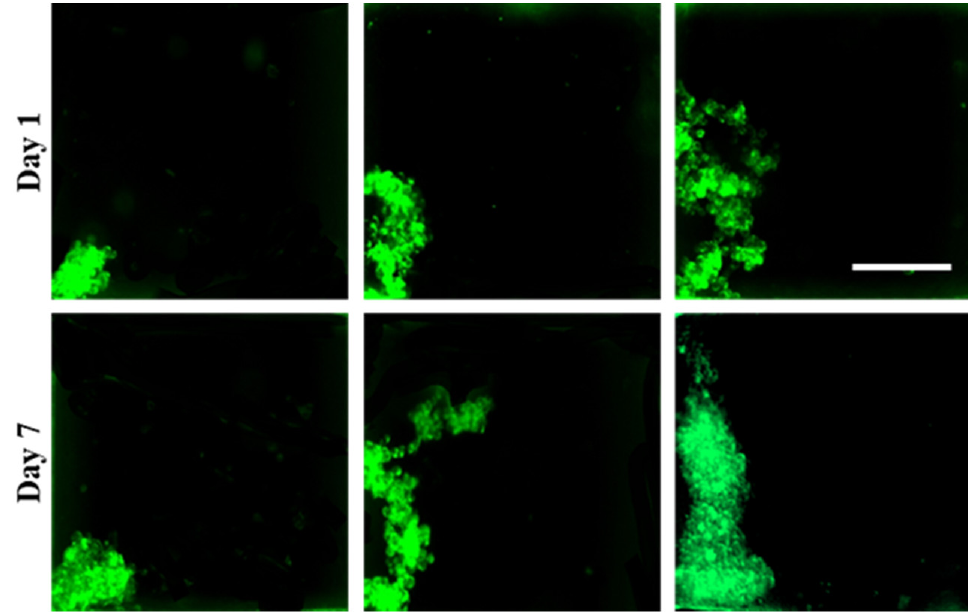
Figure A1. MDA-MB-231 cells stick to the corners of the wells.